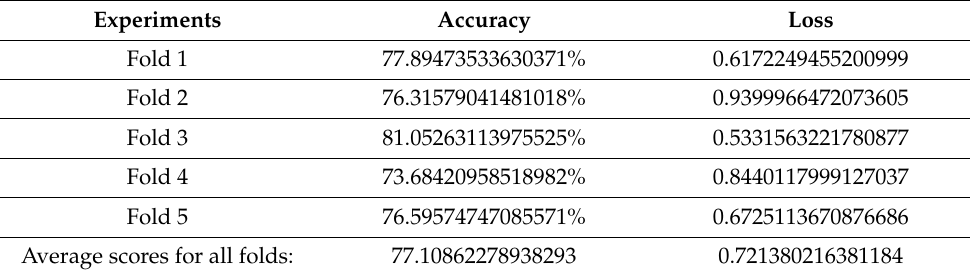
Table 13. Cross fold k = 5 validation on the Surveillance Fight dataset.